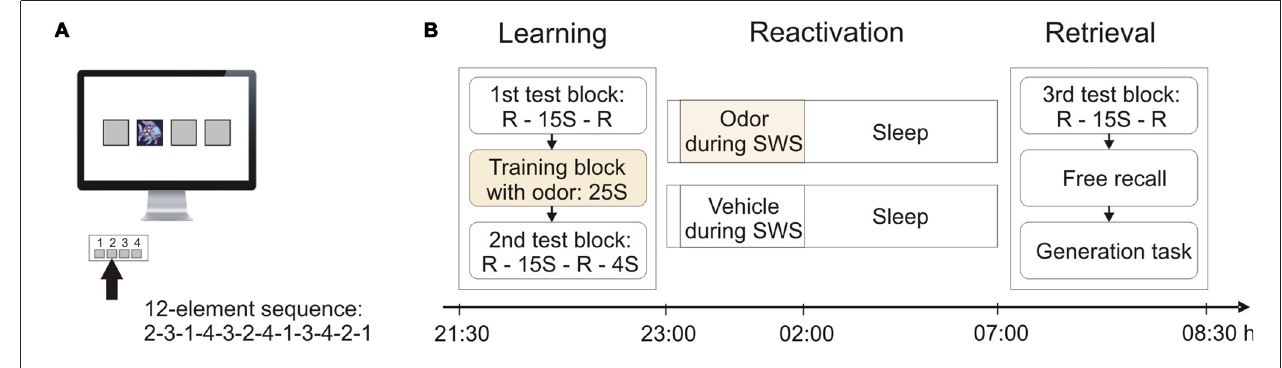
FIGURE 1 | Serial reaction time task (SRTT) and experimental procedures. (A) Participants were instructed to press one of four buttons whenever a visual cue (picture of a fish) appeared in one of four corresponding squares on the screen. Unbeknownst to the participants, the appearance of the cue followed a repeating 12-element sequence. (B) During learning, participants performed on the SRTT in a 1st test block with 15 sequence (S) repetitions flanked by random (R) trials, followed by the training block containing 25 sequence repetitions with concurrent odor presentation, and the 2nd test block with 15 sequence repetitions flanked by random trials and four final sequence repetitions. During the subsequent 8-h sleep period, half of the subjects were again presented with the odor during slow wave sleep (SWS), whereas the other half received an odor-less vehicle. At retrieval testing in the morning, participants performed on a 3rd test block of the SRTT and were then tested on their explicit knowledge about the sequence in a free recall test and a generation